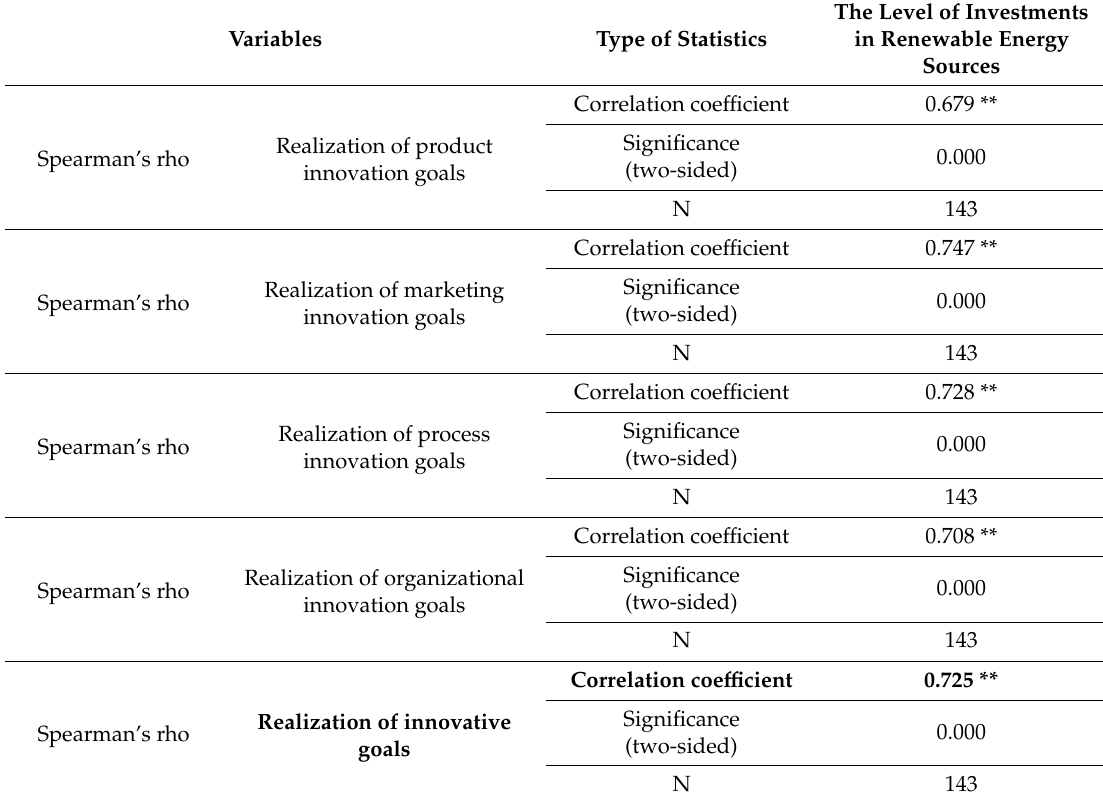
Table 6. Correlation between the level of investments in renewable energy sources and the realization of innovative goals.